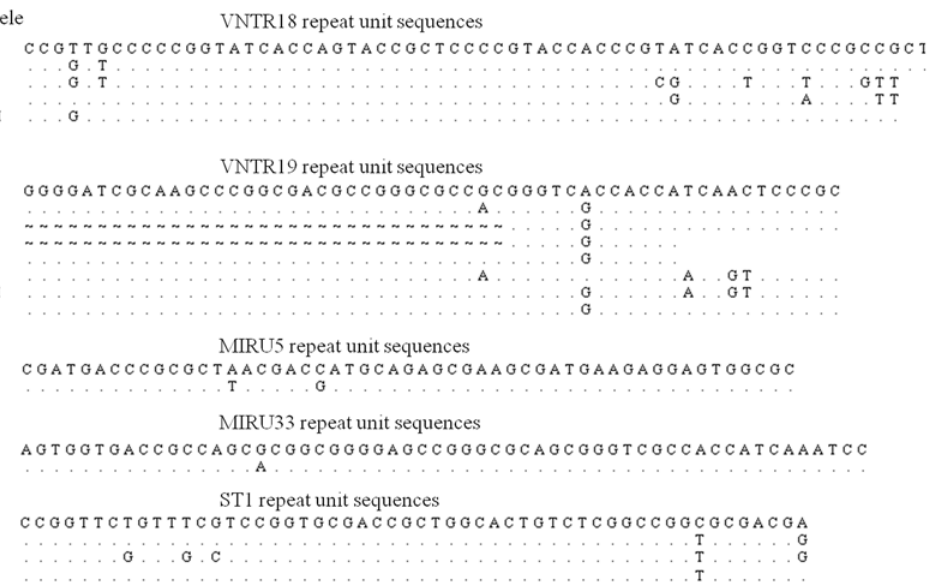
Fig 1. Sequence variation of tandem repeat units. Dashes indicate a base deletion, and dots indicate an identical base compared to the reference sequence. Letters on the left indicate allele sequence